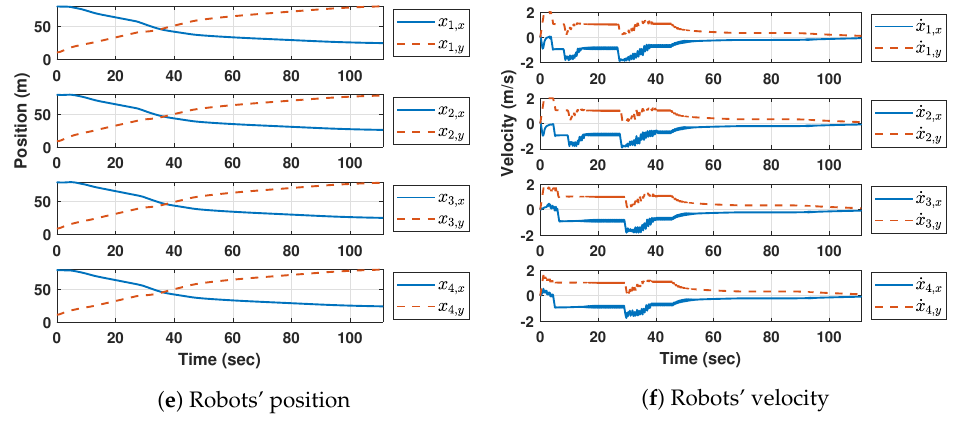
Figure 10. Training results: Scenario 2.